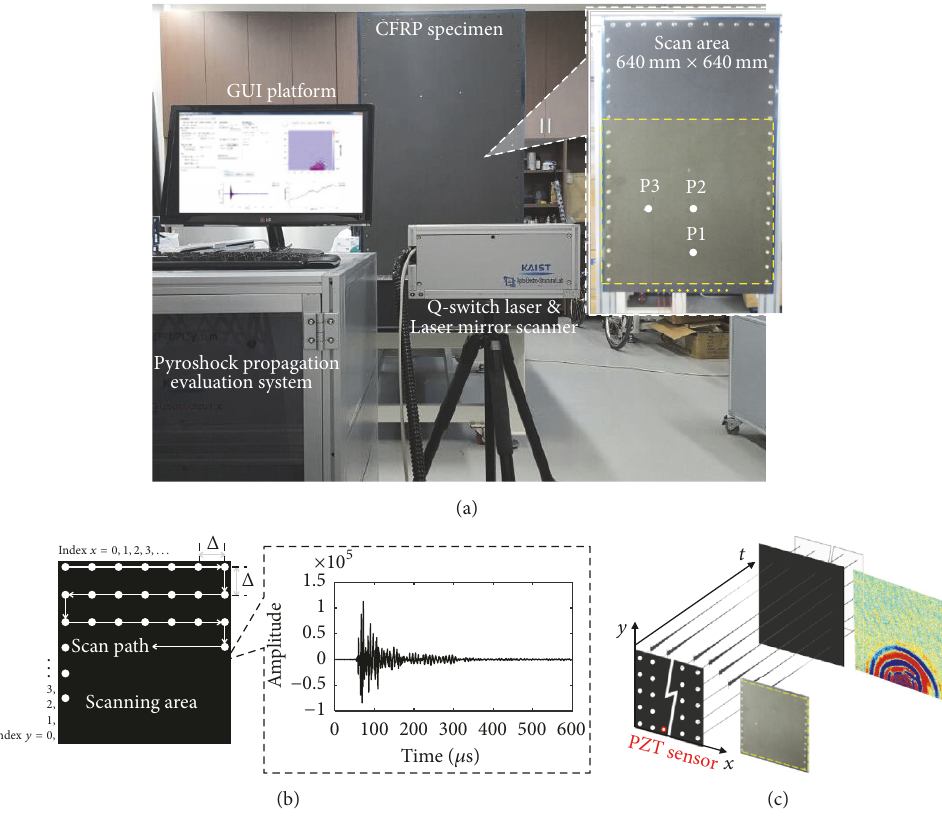
Figure 10: (a) Laser shock measurement setup. (b) Laser scanning process and laser shock time domain signal at an arbitrary point. (c) Four-dimensional laser scanning data